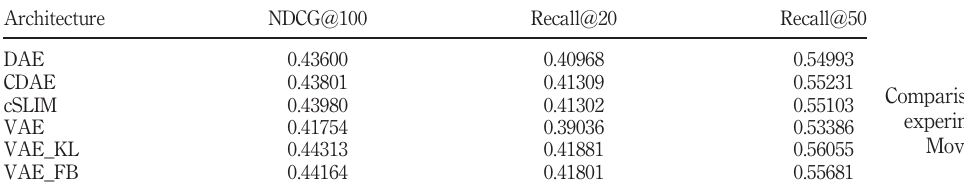
Table II. Comparison of